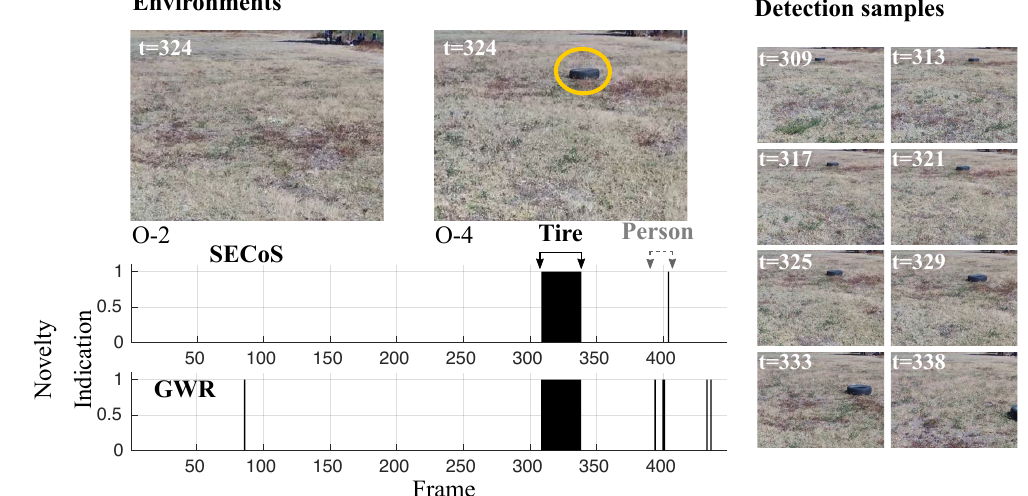
Figure 16. Visual results in novelty detection on dataset D-3 (the tire as the novel object, and the person as the normal